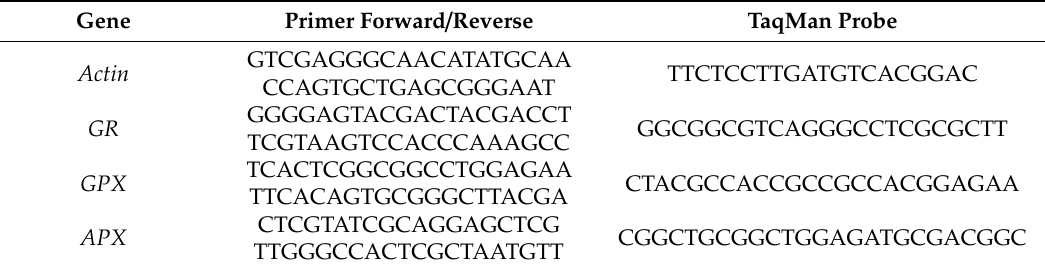
Table 2. Sequences of primers and TaqMan probes for the target and reference genes in Lolium multiflorum / Festuca arundinacea introgression forms: chloroplastic L-ascorbate peroxidase (APX), catalase (CAT), chloroplastic iron superoxide dismutase (Fe-SOD), mitochondrial manganese superoxide dismutase (Mn-SOD), chloroplastic copper / zinc superoxide dismutase (Cu / Zn-SOD), chloroplastic glutathione reductase (GR), chloroplastic glutathione peroxidase (GPX), and reference actin, used in RT-qPCR